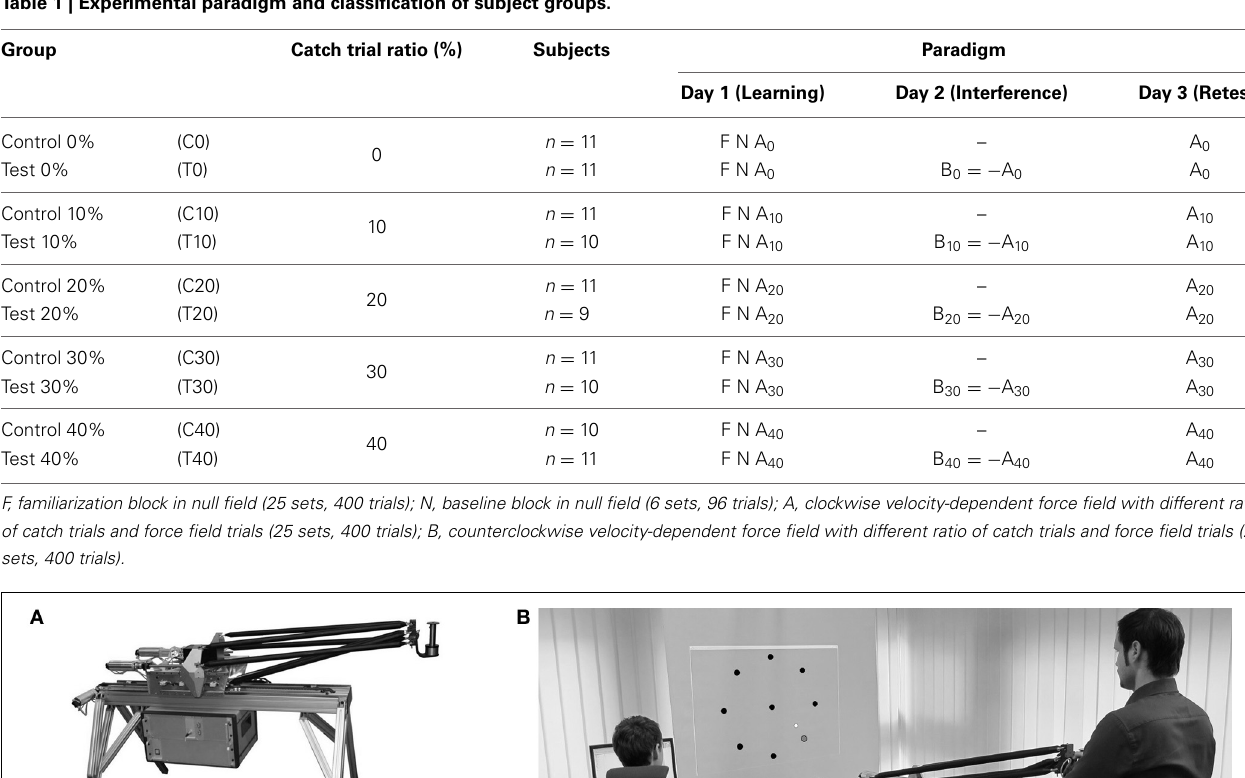
Table 1 | Experimental paradigm and classification of subject groups.